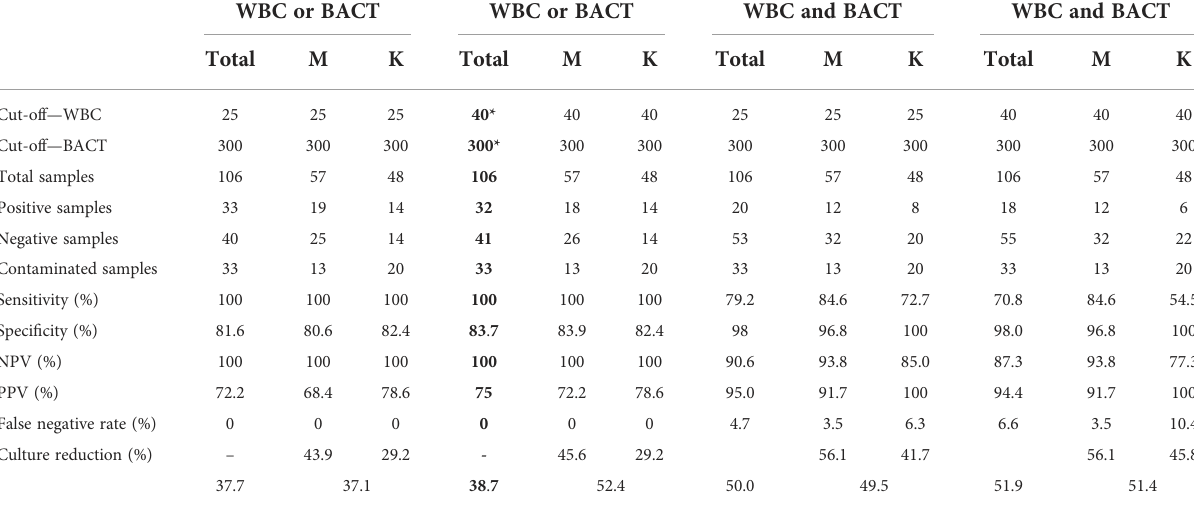
TABLE 7 Evaluation of different cut-off points and parameters combinations to predict positive urine culture (*adopted in this study cut-offs). WBC or BACT WBC or BACT WBC and BACT WBC and BACT